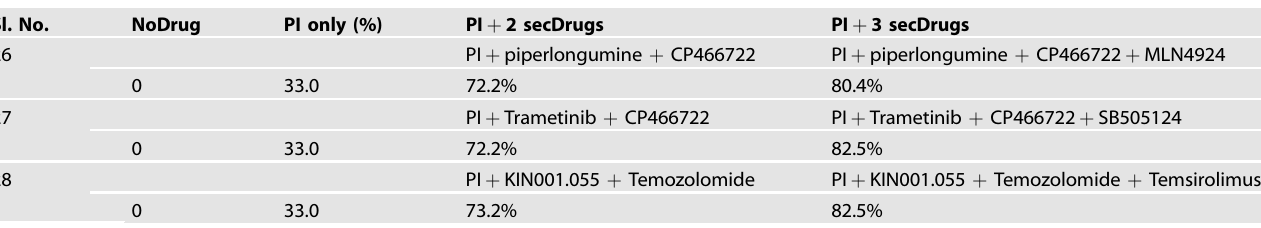
resistant myeloma cell lines compared to untreated control at increasing concentrations of secondary drugs.